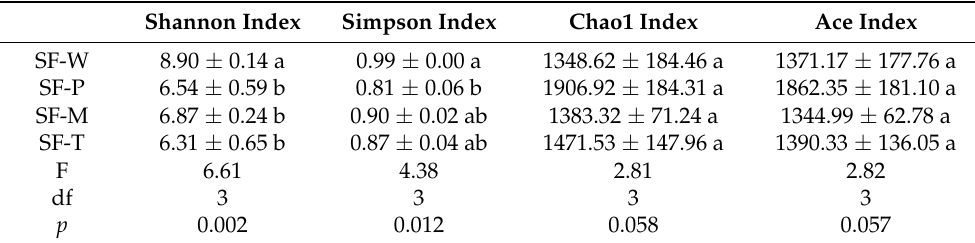
Table 2. Alpha diversity indices of the bacteria in the gut of larval S. frugiperda . Figure 2. Relative abundance of bacterial taxa in the intestine of larval S. frugiperda fed on four host plants at different classification levels. ( A ): phylum level; ( B ): genus level. Shannon Index